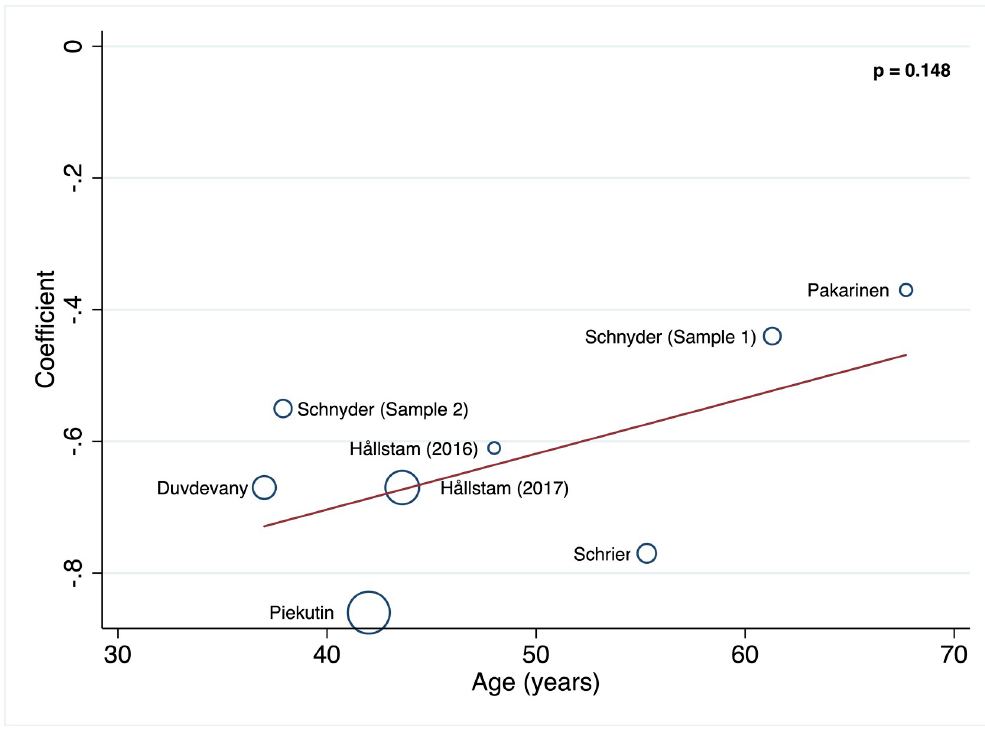
Fig 3. Random-effects meta-regression models for the association between SOC and depression in age.